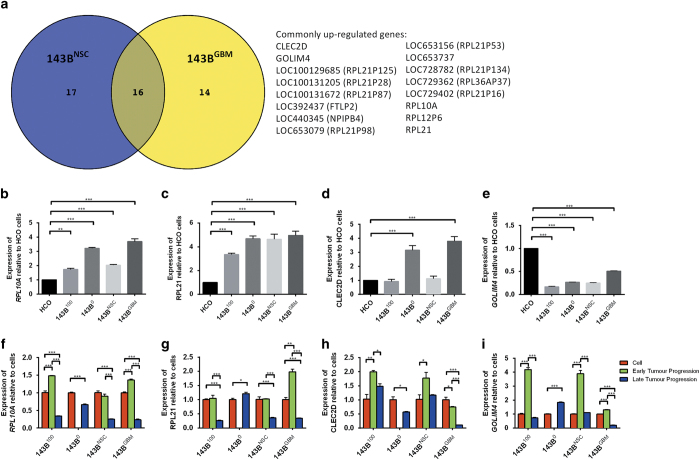
Differential gene expression. (a) Sixteen common genes that were upregulated at early tumour progression but downregulated at late progression between 143BNSC and 143BGBM tumours; (b) expression of RPL10A in all 143B cell lines relative to HCO cells; (c) expression of RPL21 in all 143B cell lines relative to HCO cells; (d) expression of CLEC2D in all 143B cell lines relative to HCO cells; (e) expression of GOLIM4 in all 143B cell lines relative to HCO cells; (f) expression of RPL10A in all 143B cells and at early and late progression; (g) expression of RPL21 in all 143B cells and at early and late progression; (h) expression of CLEC2D in all 143B cells and at early and late progression; and (i) expression of GOLIM4 in all 143B cells, and at early and late progression (*P<0.05; **P<0.01; ***P<0.001).